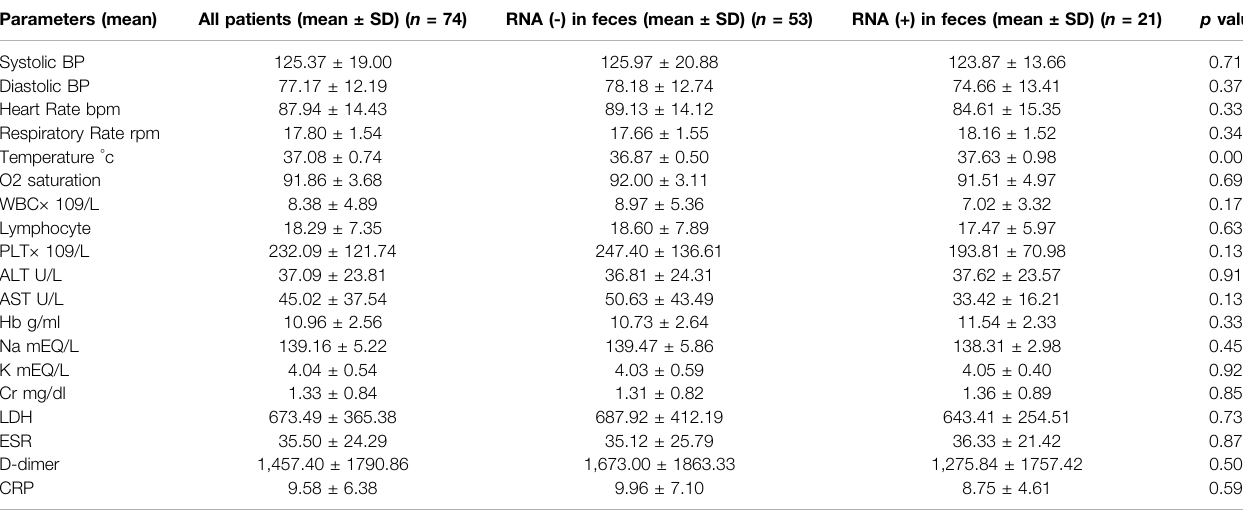
TABLE 5 | Laboratory Parameters of COVID-19 patients with feces on admission. Parameters (mean) All patients (mean ± SD) ( n = 74) Systolic BP